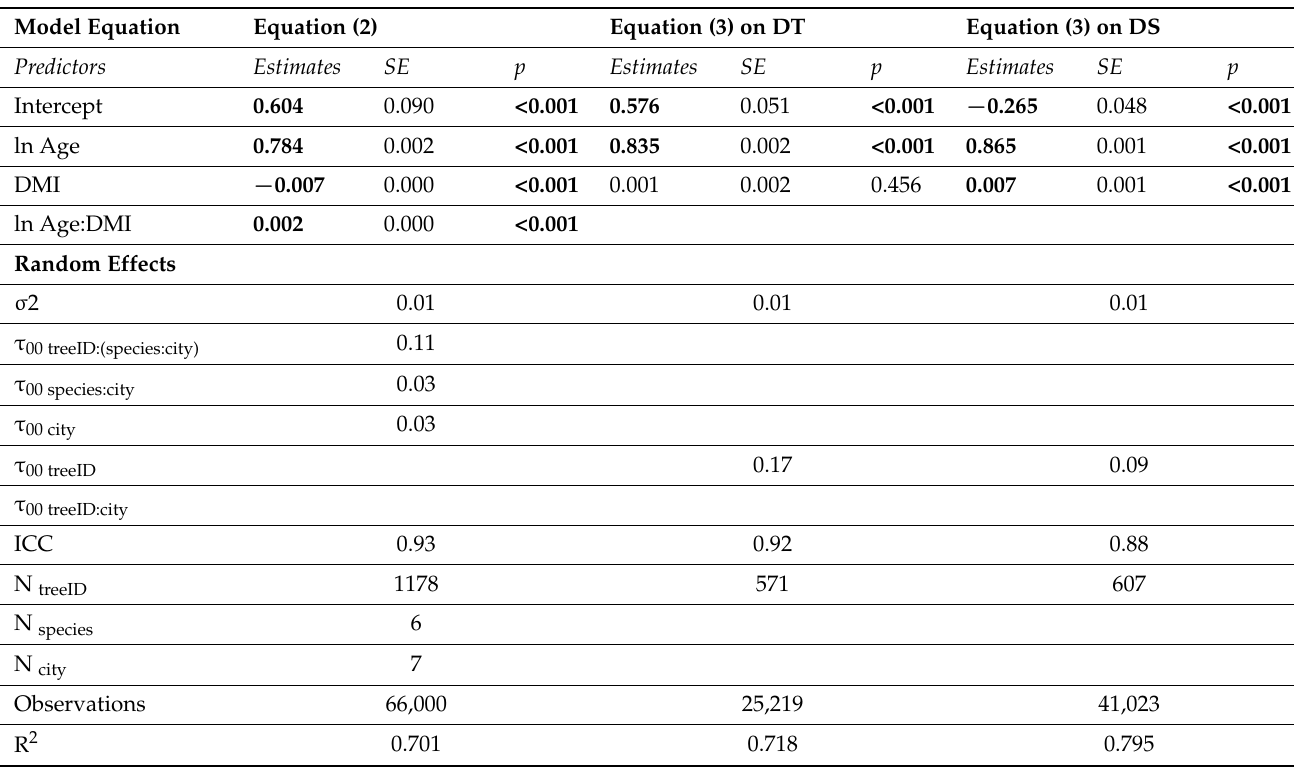
Table A1. Statistical results of the linear mixed effect model as described by Equations (2) and (3). DT = Drought tolerant, DS = Drought sensitive. Significant p values ( p < 0.05) are shown in